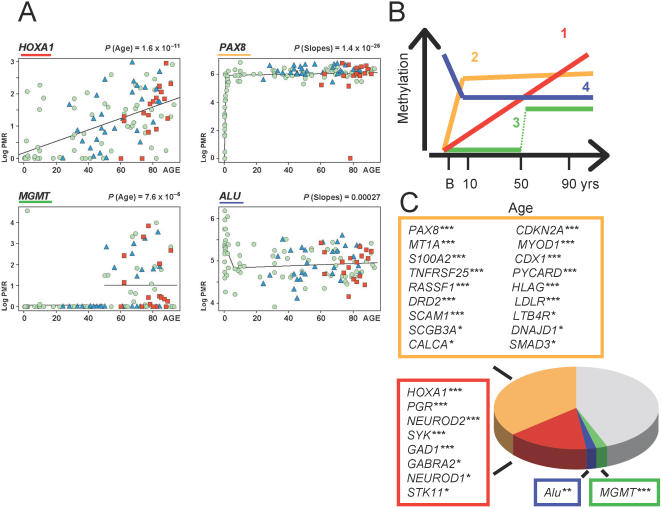
Four developmental profiles for cortical DNA methylation.(A) Associations of log-transformed PMR values (ln(PMR+1); y-axis) with age (x-axis) for several representative genes. Trends are studied using linear regression. HOXA1 shows a linear association. MGMT-M2B shows a non-linear shift, with the P-value referring to a T-test of the difference in mean methylation value for subjects under or over 50 years of age. For the biphasic linear trends of PAX8 and the ALU sequence ALU-M1B (Table S2) , the P-values refer to a test of change of slope. Green dots = controls, blue triangles = schizophrenia and red squares = Alzheimer's subjects. (B) Schematic summary of the four different types (1–4, see text for details) of developmental methylation profiles in human temporal cortex across the lifespan (x-axis, B = birth), as illustrated by the representative examples in (A). (C) Listings and proportion of gene loci (total = 48; excluding AR and FAM127A which showed gender-specific methylation) that show significant age-dependent methylation changes: colors refer to the scheme in (B). Gray sector refers to the subset of loci without a significant age effect. N = 125 subjects. All p-values are adjusted for diagnosis; *** p<0.0001, ** p<0.001, * p<0.05.